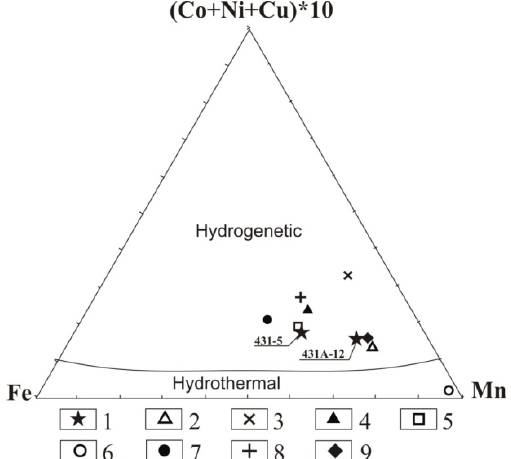
Figure 6. Plot of Pacific Fe-Mn deposits of different genesis on the Mn-Fe-(Cu+Co+Ni) × 10 ternary diagram [28]. 1—sandy-gravel Fe-Mn fragments from the Yōmei Guyot (Holes 431, 431A) (Table 3); 2—Fe-Mn crust from the Kashevarov Trough, the Sea of Okhotsk, [29]; 3—Fe- Mn nodules from the Peru Basin, [30]; 4—Fe-Mn crust from the Seth Guyot, Markus-Wake cluster, [33]; 5—Fe-Mn crust from the Detroit Guyot, Emperor Ridge, [34]; 6—Fe-Mn crust from the Belyaevsky Volcano, the Sea of Japan, [35]. Our unpublished data: 7—Fe-Mn crust from the Zubov Guyot, Marshall Island cluster; 8—Fe-Mn crust from the Govorov Guyot, Magellan Seamounts [32]; 9—Fe-Mn crust from the Zonne Chain, the Sea of Okhotsk, [31].